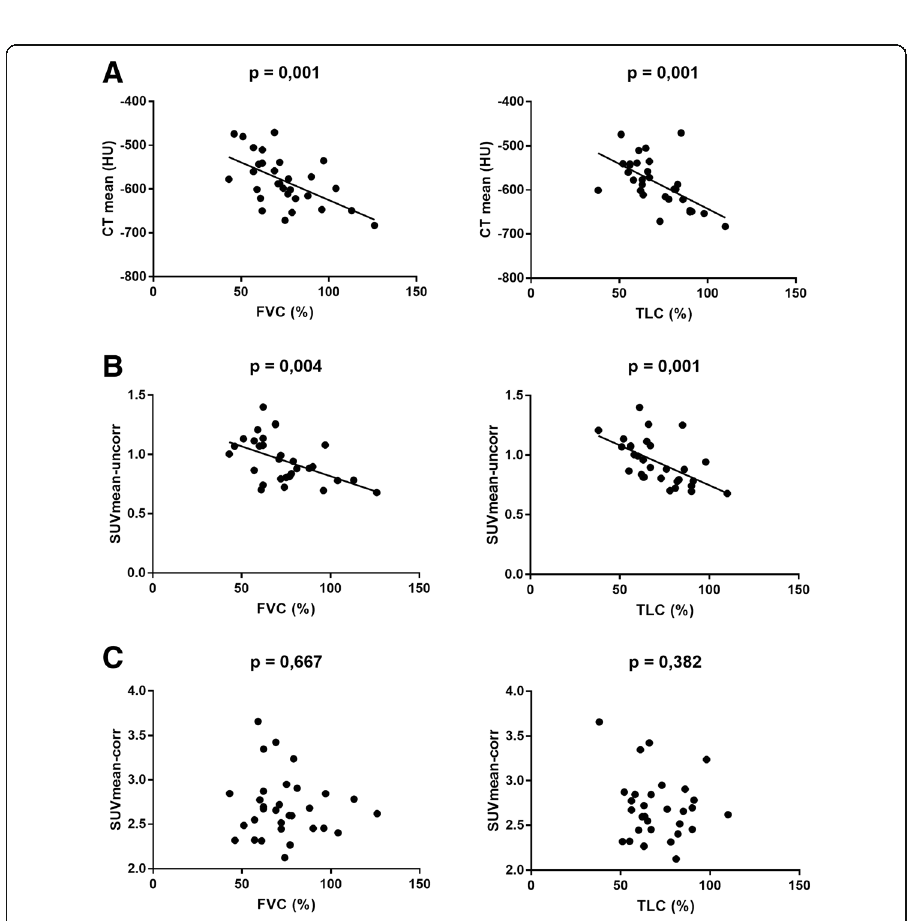
Fig. 3 Correlation between SUV values or the lung density (CTmean) and the lung volumes (FVC, TLC). The CTmean ( a ) and the SUVmean-uncorr ( b ) are significantly correlated with lung volumes, while the SUVmean-corr ( c ) is not. FVC = Forced vital capacity. TLC = Total lung